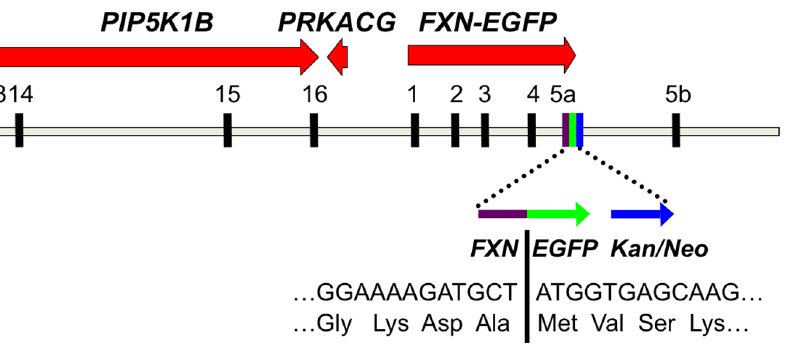
Figure 1. FXN-EGFP genomic reporter construct. Diagrammatic representation of the BAC genomic DNA fragment containing the FXN-EGFP genomic reporter construct. The sequence includes exons 13–16 of the PIP5K1B gene and the PRKACG gene upstream of the FXN locus, and about 23 kb of additional sequence downstream of exon 5b. The exon 5a–EGFP–Kan/Neo region is shown in greater detail.